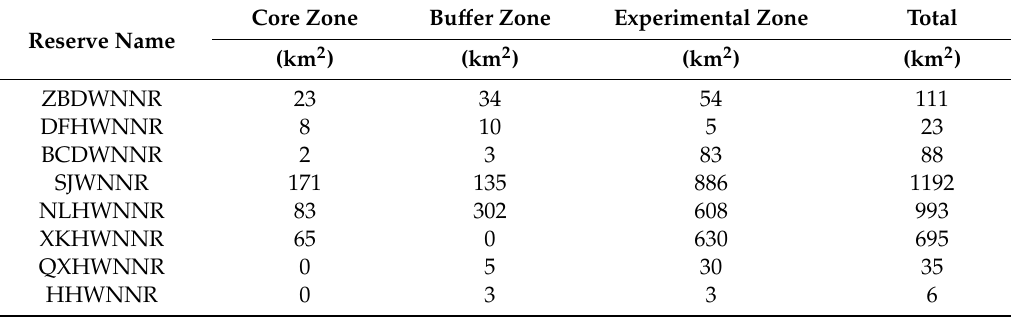
Table 3. Cropland areas in the eight Wetland National Nature Reserves (WNNR) in the SJP. Reserve